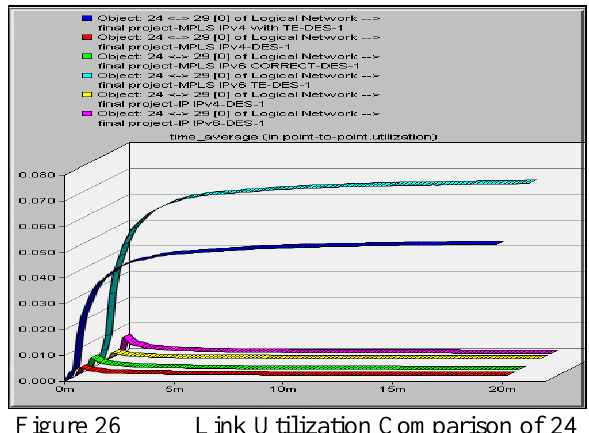
Figure 26 Link Utilization Comparison of 24 to 29 Link